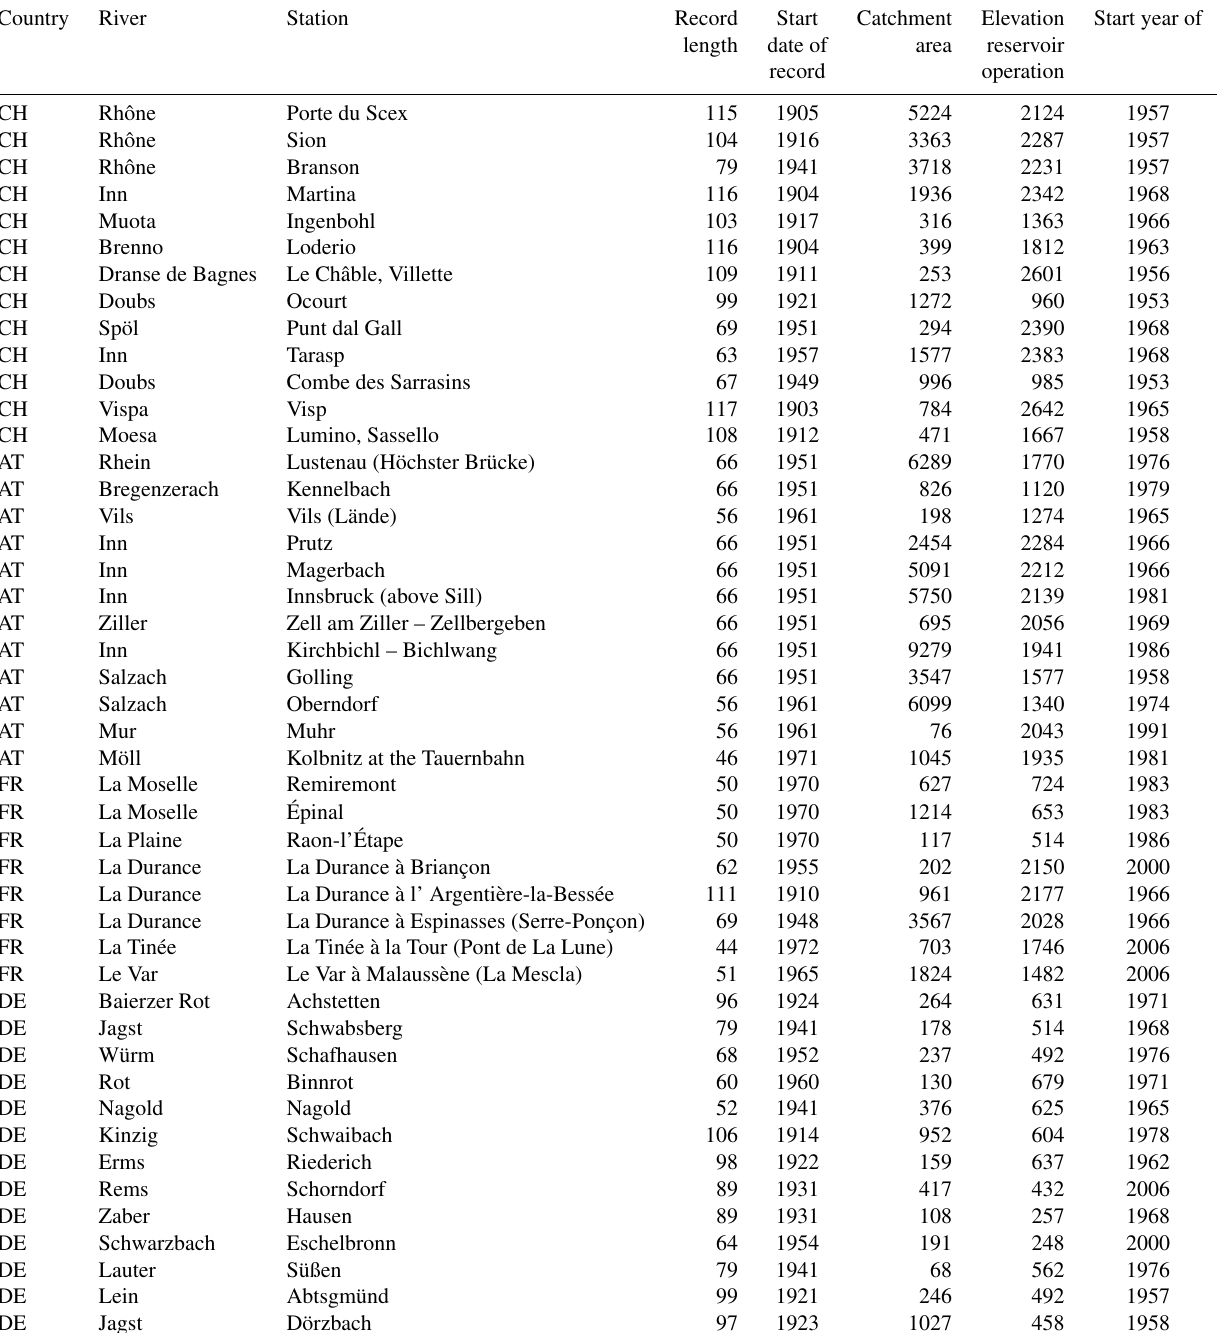
Table A1. Catchment characteristics of the 74 Alpine catchments used in the analysis, including country, name of river, location of